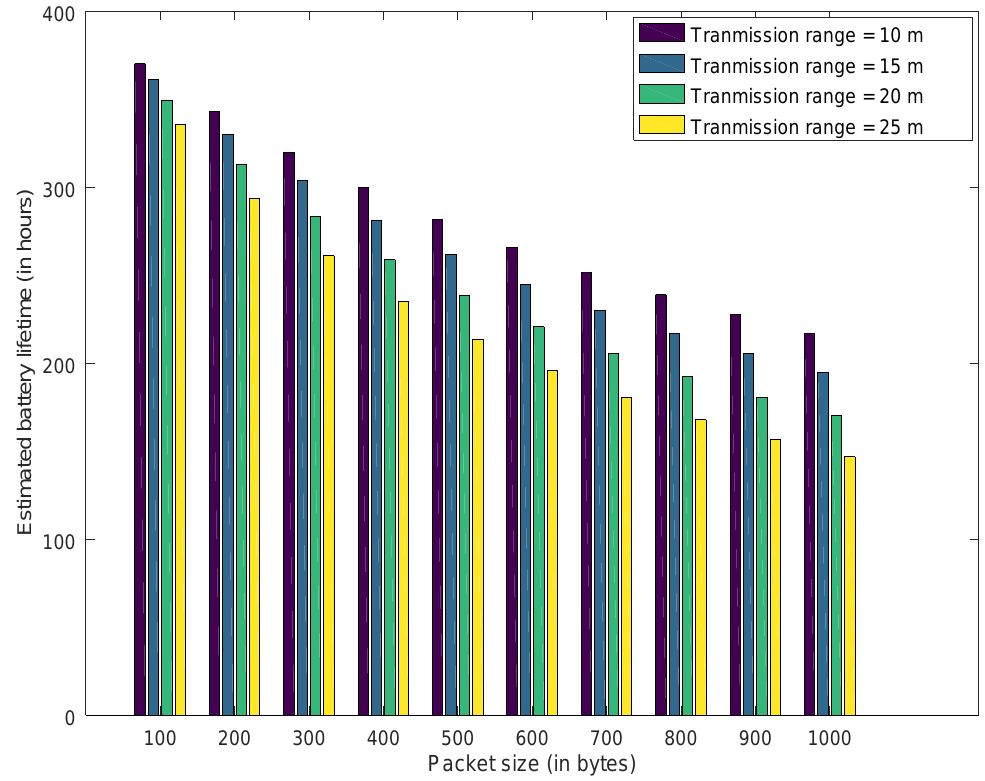
Figure 14. Estimated Battery Lifetime—Best